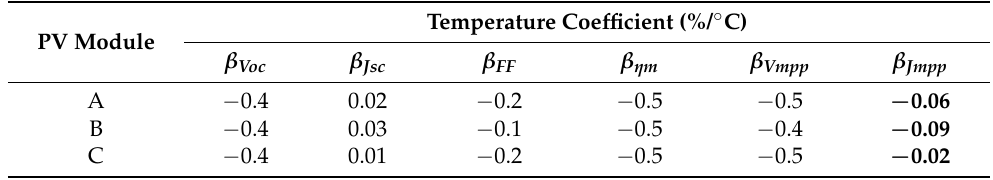
Table 4. Average temperature coefficients of the 3 solar panels.